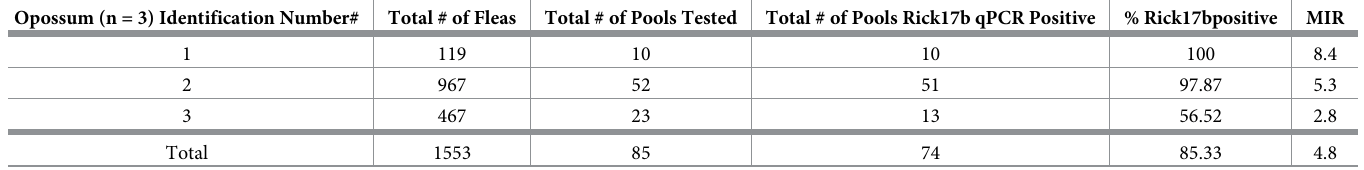
Table 2. Summary of Rickettsia genus-specific qPCR assay (Rick17b) assessment of Ctenocephalidesfelis pools (n (cid:20) 20 individual fleas/pool) from 3 opossums at the mobile home community in Los Angeles County, California. Opossum (n = 3) Identification